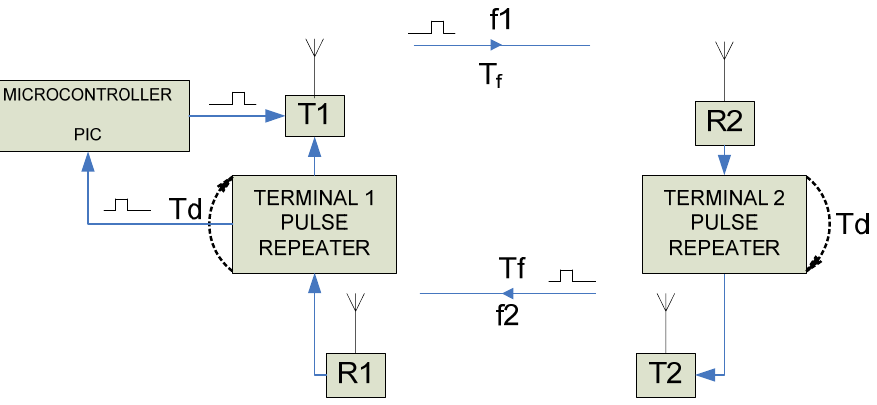
Figure 1. Block diagram of the prototype